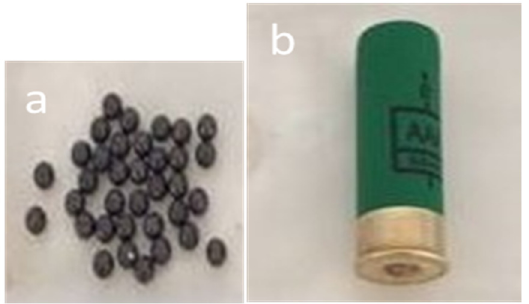
Figure 1. ( a , b ). Shotgun cartridge (35 g; 5.2 mm pellets) used for helicopter shooting.